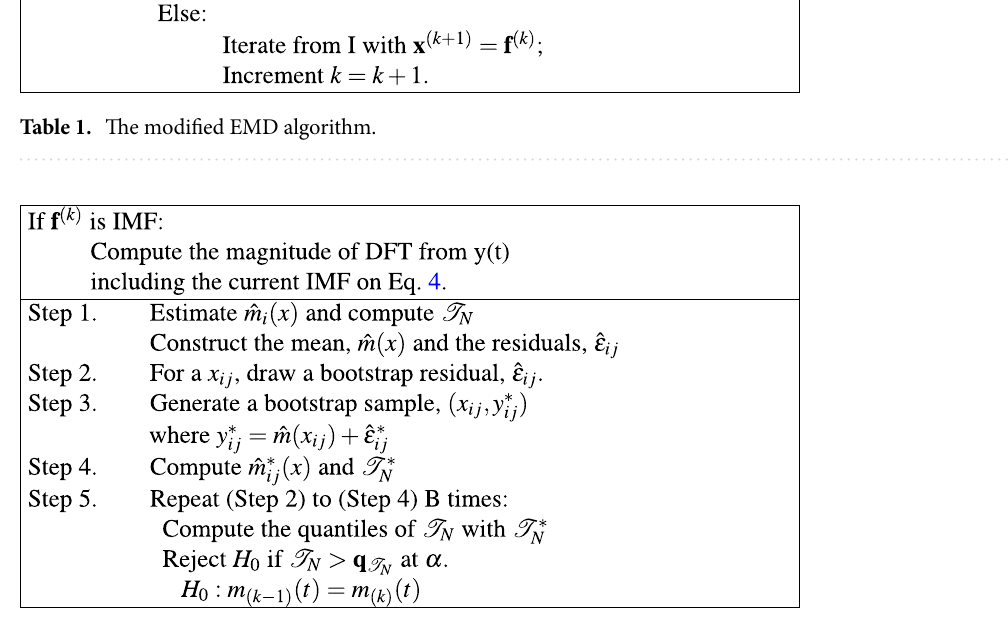
Table 2. The stopping rule: determination of